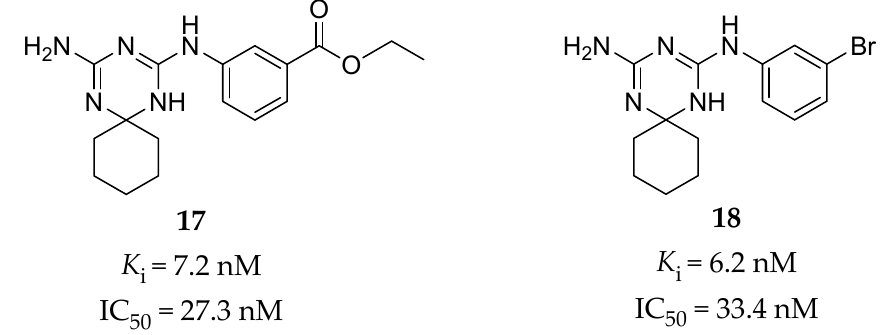
Figure 5. Representative triazine derivatives as selective 5-HT 2B R antagonists [65]. The predicted binding mode for compound 17 was verified by SAR analysis of a series of structural analogs [65]. The key interactions contain a typical salt bridge interaction between the protonated triazine ring and the carboxyl group of the conserved D135 3.32 residue, hydrogen bonds between one amino (NH) group on the triazine ring and